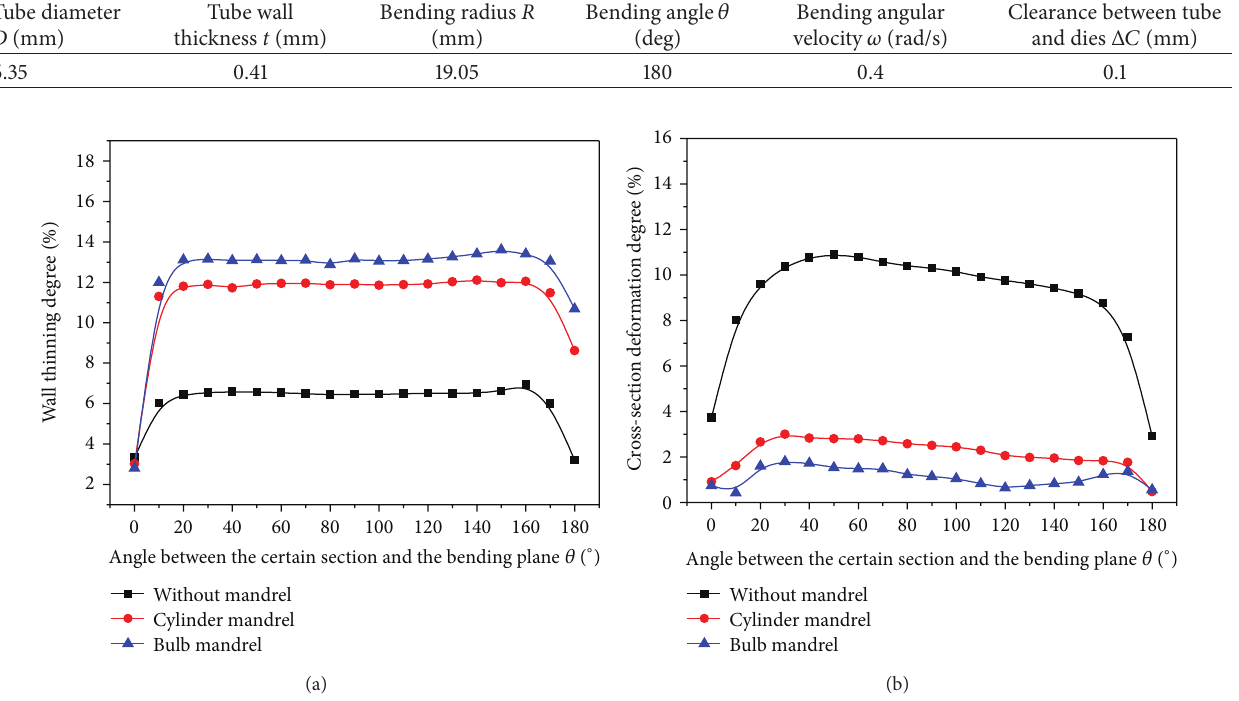
Figure 7: Effect of mandrel type on cross section quality: (a) wall thinning; (b) cross section